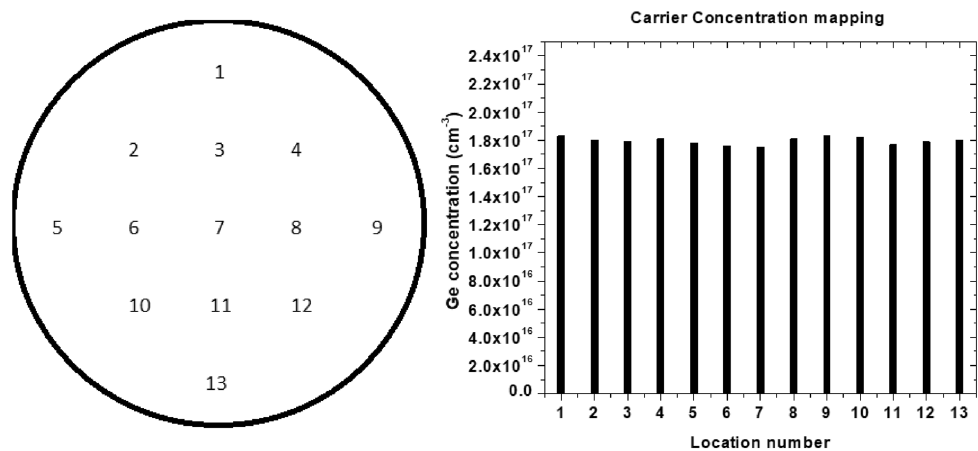
Figure 7. The carrier concentration of each location on wafer